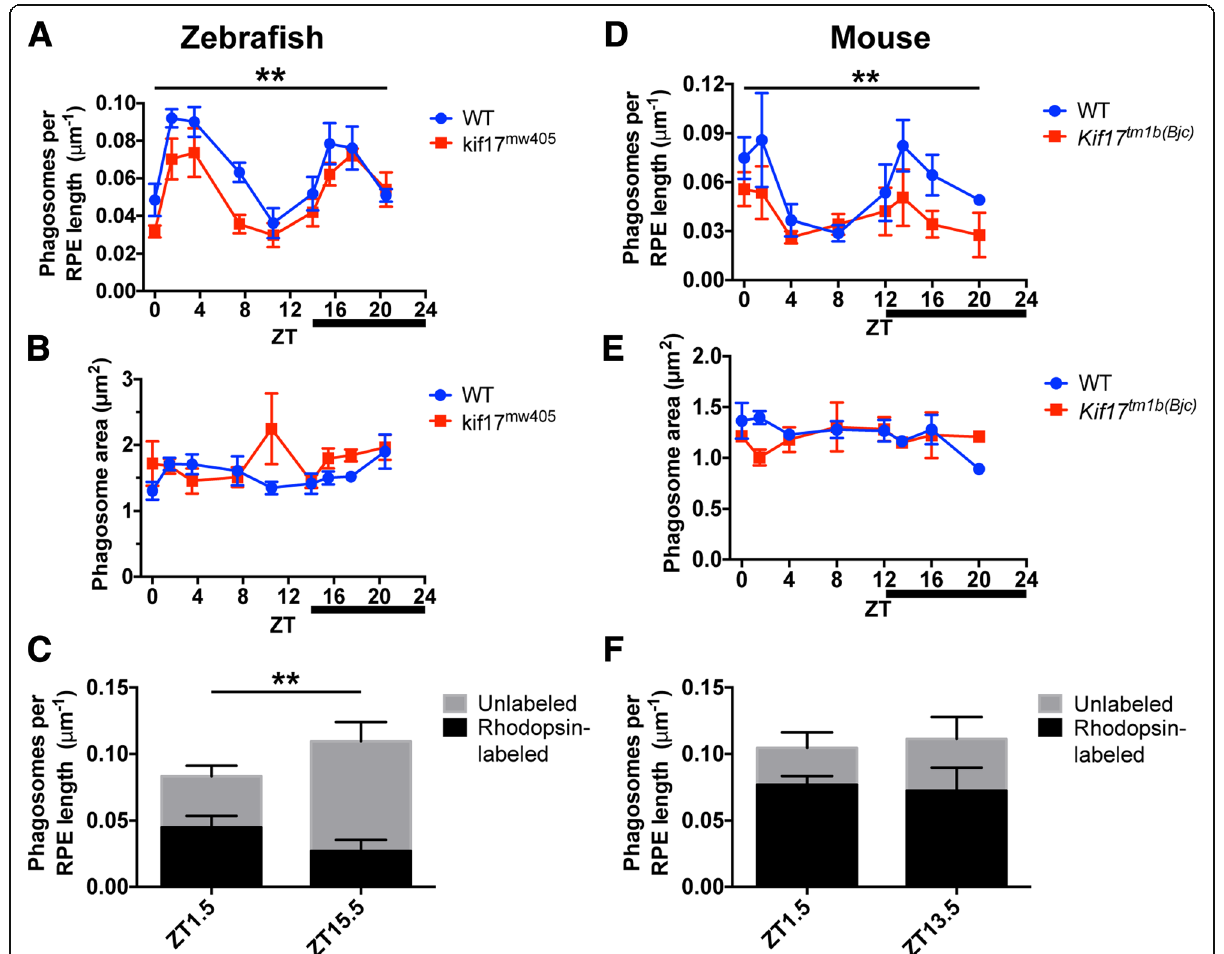
Fig. 5 Loss of kif17 diminishes disc shedding. a TEM analysis of phagosome number in 14 dpf wild-type ( n = 5 larvae at each timepoint, 1400 ± 97 μ m of RPE measured at each timepoint) and kif17 mw405 ( n = 5 larvae at each timepoint, 1469 ± 36 μ m of RPE measured at each timepoint) zebrafish collected at nine discrete timepoints following light onset (ZT 0). Dark onset begins at ZT 14 (indicated by dark bar). Two-way ANOVA was performed to determine significance in both phagosome number rhythmicity throughout the timepoints ( p < 0.0001, ****) as well as between genotypes ( p = 0.0011, **). b TEM analysis of phagosome size in 14 dpf wild-type ( n = 5 larvae at each timepoint, 93 ± 14 phagosomes measured at each timepoint) and kif17 mw405 ( n = 5 larvae at each timepoint, 79 ± 10 phagosomes measured at each timepoint) zebrafish. c Immunogold labeling of rhodopsin-containing phagosomes in 14 dpf wild-type retina at either the morning peak of disc shedding, ZT 1.5 ( n = 5 larvae, 1738 μ m of RPE), or the evening peak, ZT 15.5 ( n = 5, 1341 μ m of RPE). Two-way ANOVA was performed to determine significance in the interaction between the time of day and the concentration of rod or cone phagosomes ( p = 0.0082, **). There were no statistical differences in the total number of phagosomes between the morning or night peak. Bonferroni ’ s multiple comparisons post-hoc test was performed to determine significance in the increased of unlabeled phagosomes between morning and night ( p = 0.0158, *). d TEM analysis of phagosome number in 2 – 4 month wild-type ( n = 3 mice at each timepoint, 979 ± 42 μ m of RPE measured at each timepoint) and Kif17 tm1b(Bjc) ( n = 3 mice at each timepoint, 940 ± 45 μ m of RPE measured at each timepoint) mice collected at eight discrete timepoints following light onset (ZT 0). Dark onset begins at ZT 12 (indicated by dark bar). Two-way ANOVA was performed to determine significance in both phagosome number rhythmicity throughout the timepoints ( p = 0.0300, *) as well as between genotypes ( p = 0.0096, **). e TEM analysis of phagosome size in 2 – 4 month wild-type ( n = 3 mice at each timepoint, 54 ± 7 phagosomes measured at each timepoint) and Kif17 tm1b(Bjc) ( n = 3 mice at each timepoint, 35 ± 4 phagosomes measured at each timepoint) mice. f Immunogold labeling of rhodopsin-containing phagosomes with B630 rhodopsin antibody in mouse retina at either the morning peak of disc shedding, ZT 1.5 ( n = 5 mice, 554 μ m of RPE), or the evening peak, ZT 13.5 ( n = 5, 594 μ m of RPE). Two-way ANOVA was performed to determine no significance differences in the interaction between the time of day and the concentration of rod or cone phagosomes ( p = 0.5700) or in the differences in phagosome number between the morning or night peak ( p = 0.8076), but there was a significant increase in the total number of rod phagosomes compared to cone phagosomes ( p = 0.0074,